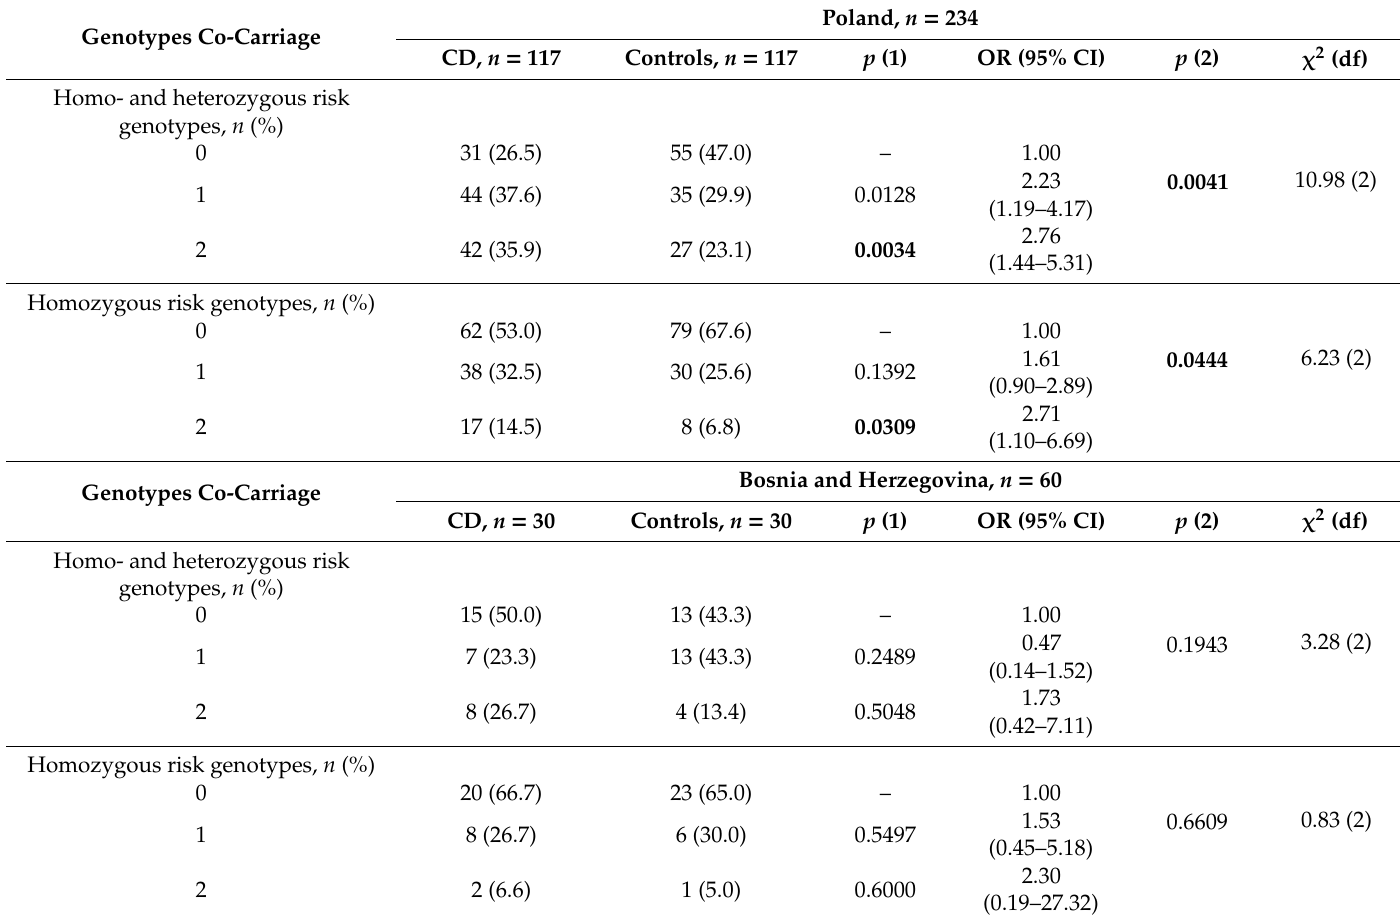
Table 3. Co-occurrence of IL23R risk genotypes in CD patients and